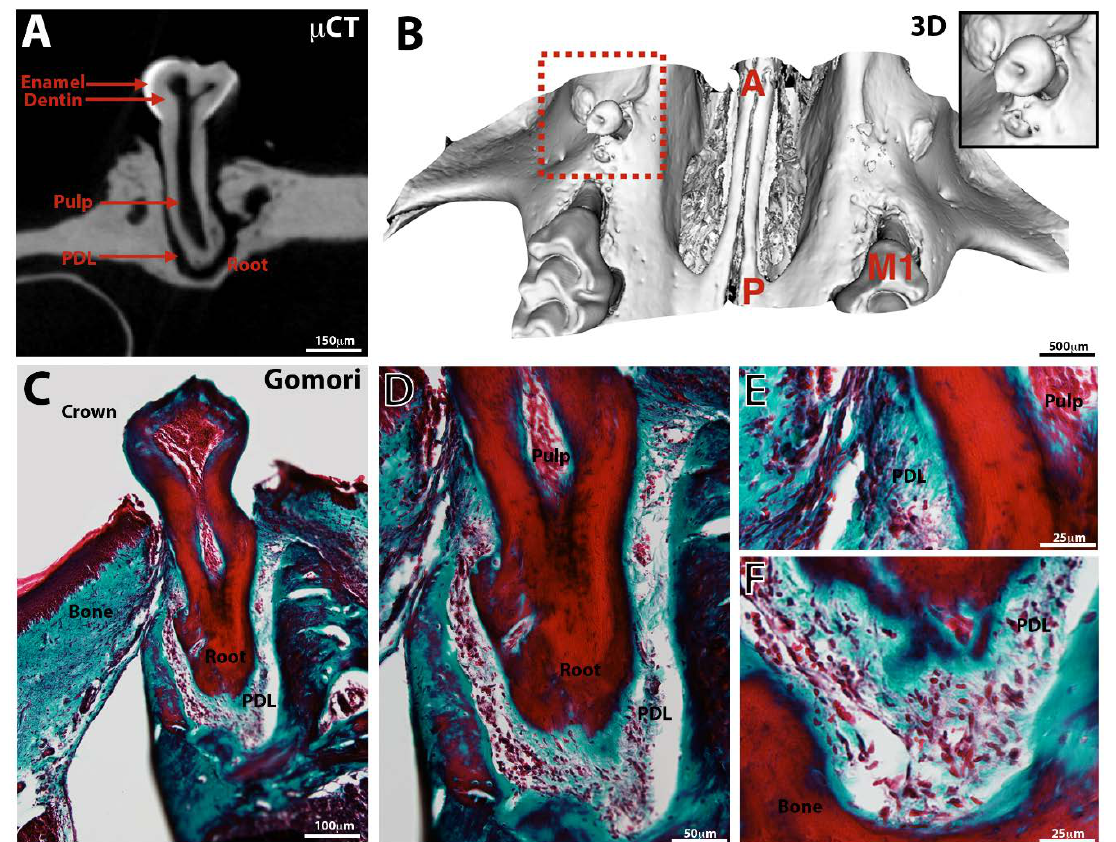
Figure 3. Observation of a non-ankylosed erupted bioengineering tooth. Microtomography ( µ CT, A ), 3D reconstruction ( B ) and histology ( C – F , Gomori staining) of a bioengineered tooth implanted with a PCL membrane for 8W in the maxillary bone. The different tissues and structures (root, crown, cusps, apical foramen, enamel, dentin, pulp, periodontal ligament) are present ( A , B ), confirmed by histology ( D – F ). Vascularized pulp ( D , E , F ) and PDL are visible ( D – F ). A = anterior, M1 = first upper molar, P = posterior and PDL = periodontal ligament.